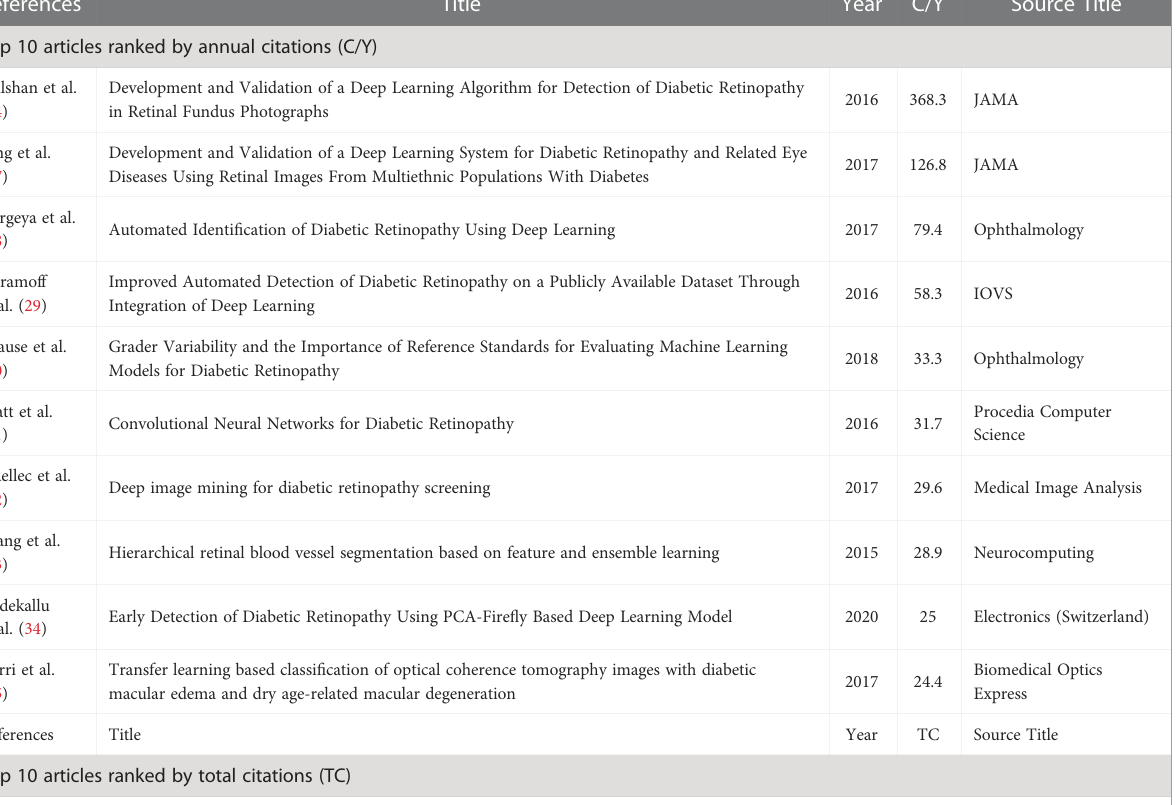
Top 10 articles ranked by total citations